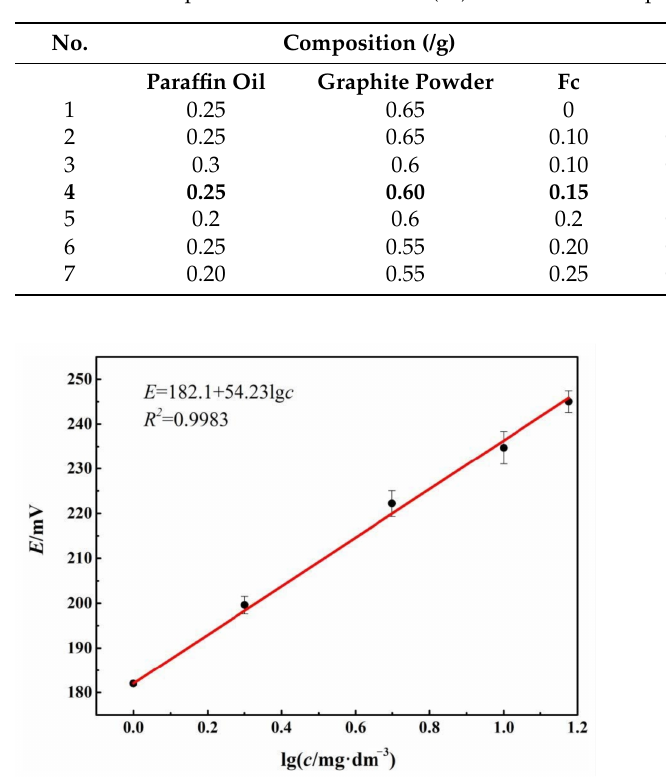
Figure 2. The linear relationship between open circuit potential (OCP) ( E /mV) and logarithm of total residual chlorine (TRC) (lg ( c /mg · dm − 3 )) of No. 4 Fc-carbon paste electrode (CPE) electrode in 3.5 wt.% NaCl